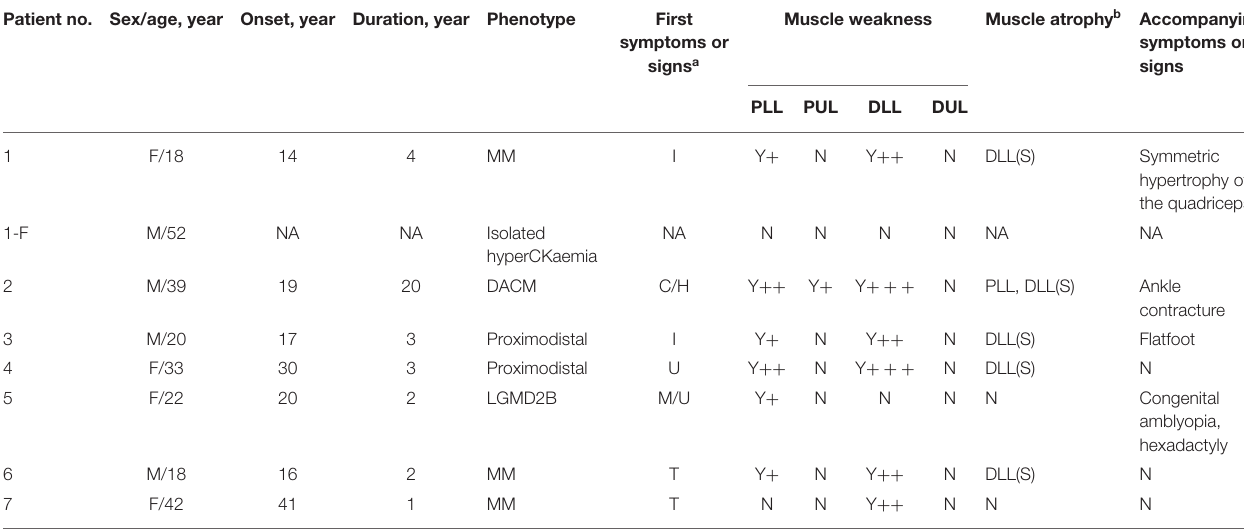
TABLE 3 | Detailed clinical description of patients with